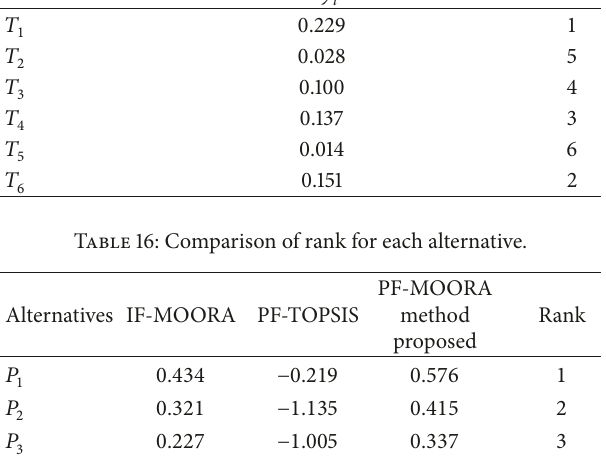
Table 15: Rank for each alternative via PF-MOORA. Alternative